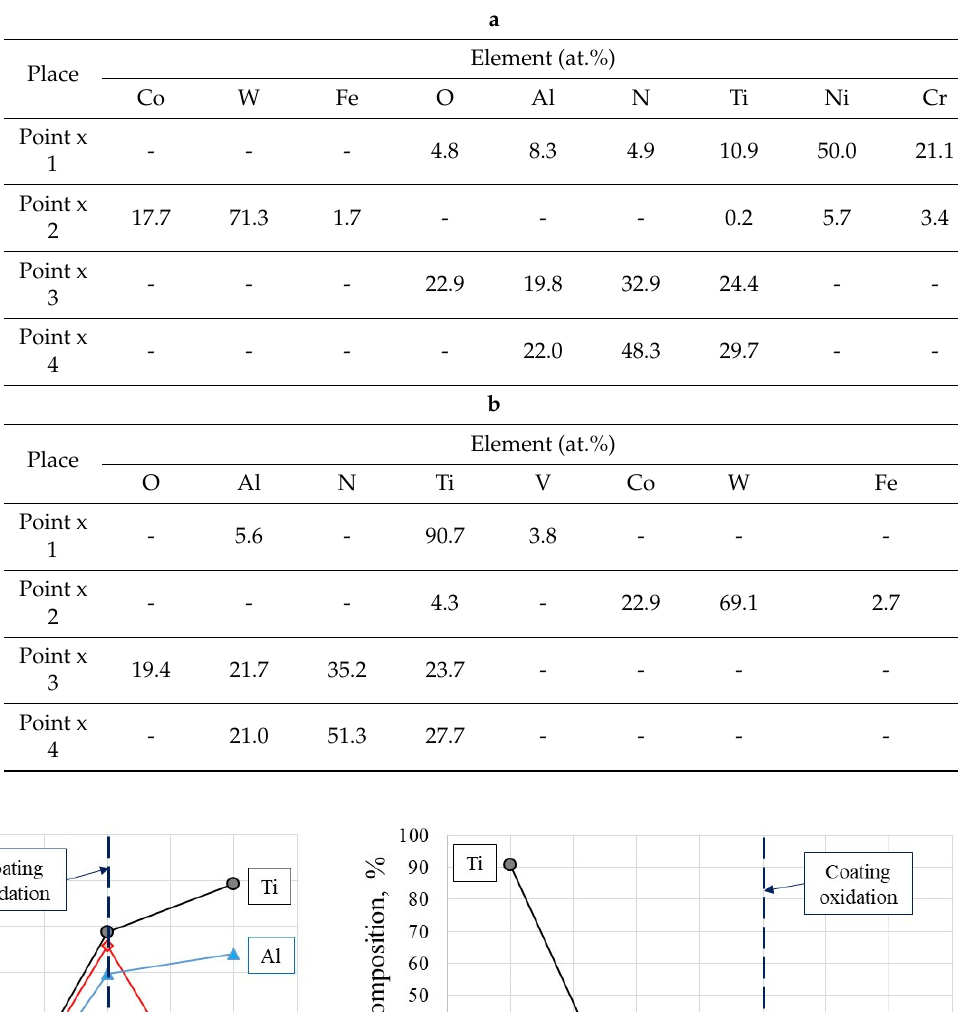
Table 6. a. At.% for oxidized layer produced in TiAlN + IN 718 dynamic diffusion couple at different points of the rake face in Figure 8a. Note that in point 1 the deposited workpiece material is detected, whereas in point 2 the WC-Co substrate is detected. On the other hand, in point 3 a fragment of Al 2 O 3 oxidized layer is detected. In point 4, the oxygen is not present, which suggest the deposited